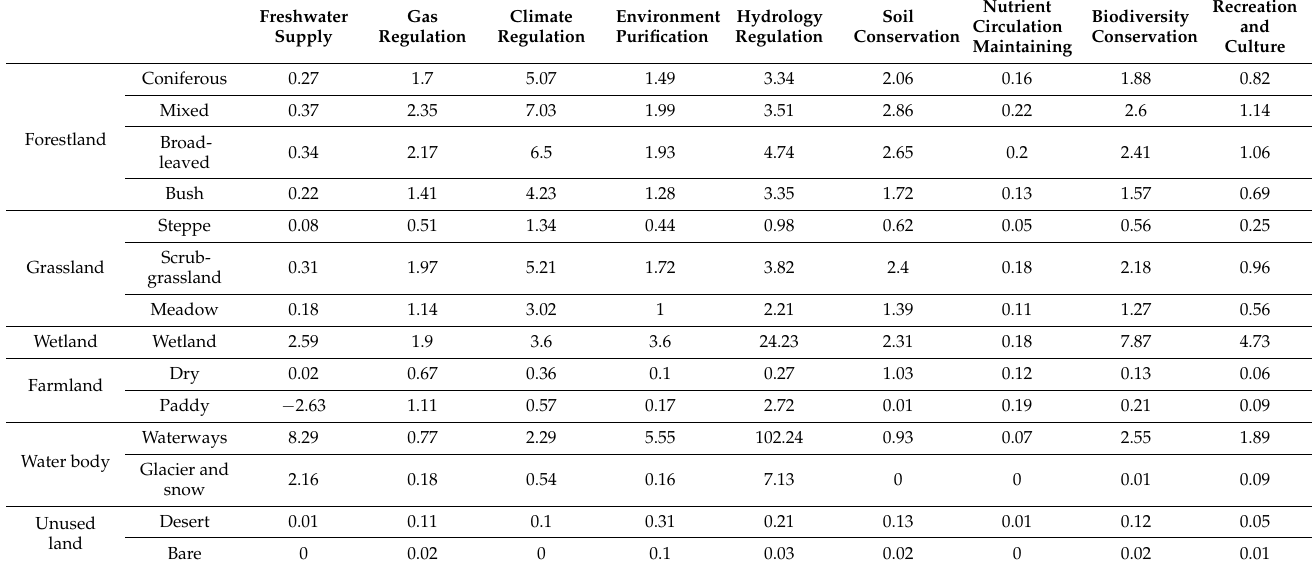
Table 2. Equivalent value per unit area of ecosystem services in China